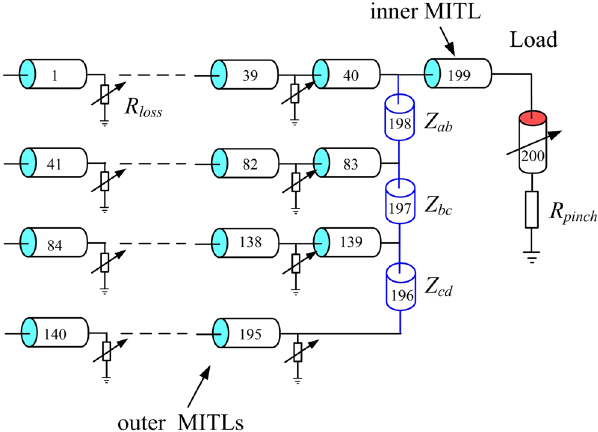
FIG. 5. TL model for the PTS MITL and z -pinch load. The TL elements 1 to 195 represent the outer MITLs. There is a variable shunting resistor R for each element accounting for loss loss current. Elements 196 to 198 are coupling inductances between different MITL levels. Element 199 is the inner MITL. All the TL elements have an electrical length of one time step (0.1 ns).The z -pinch load is denoted by a variable inductance and a constant